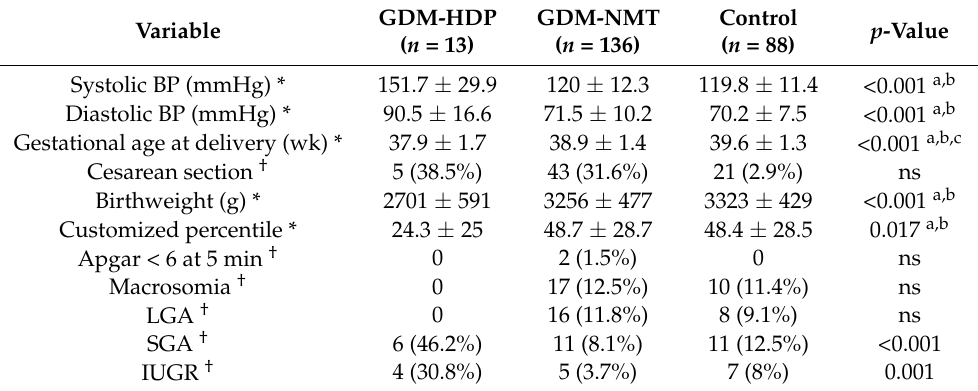
Table 2. Obstetric and perinatal outcomes in women with HDP and without